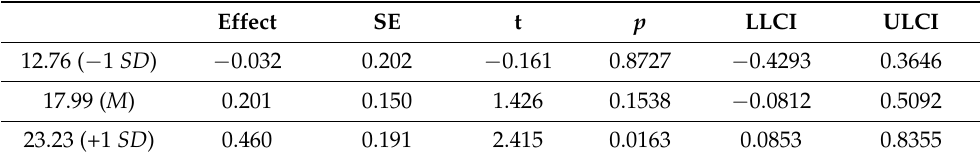
Table 6. Conditional effects of positive religious coping as a moderator for relationship between frequency of Mass attendance and life